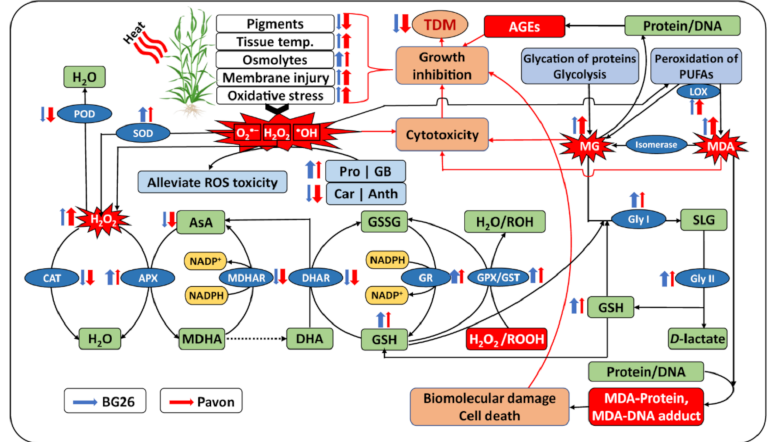
Figure 9. Schematic representation of the generation of ROS, MG and MDA due to heat stress and parametabolic reactions of AsA-GSH cycle and glyoxalase system in plants involved in ROS and MG detoxification. Red boxes and explosions indicate cellular oxidative stressors. Blue ellipses and green boxes represent the enzymes and substrate/product of the reactions, respectively. The blue and red arrows represent “BG26” and “Pavon”, respectively. The direction of the arrows indicate an overall increase (upwards) or decrease (downwards) on exposure to heat stress within a variety. Size of the arrow in terms of thickness indicates the amount/activity level with thicker arrows indicating the higher change (increase or decrease) under heat stress compared to control between the varieties. AGE- advanced glycation end product, Anth- anthocyanin, APX- ascorbate peroxidase, AsA- ascorbate, Car- carotenoids, CAT- catalase, DHA- dehydroascorbate, DHAR- dehydroascorbate reductase, DNA- deoxyribonucleic acid, GB- glycine betaine, Gly I- glyoxalase I, Gly II- glyoxalase II, GPX- Glutathione peroxidase, GR- glutathione reductase, GSH- glutathione (reduced), GSSG- glutathione (oxidized), GST- Glutathione S -transferases, H 2 O 2 - hydrogen peroxide, LOX- lipoxyge- nase, MDA- malondialdehyde, MDHA- monodehydroascorbate, MDHAR- monodehydroascorbate reductase, MG- methylglyoxal, NADPH- nicotinamide adenine dinucleotide phosphate (reduced), POD- peroxidase, Pro- proline, PUFA- polyunsaturated fatty acid, ROS- reactive oxygen species, SLG-